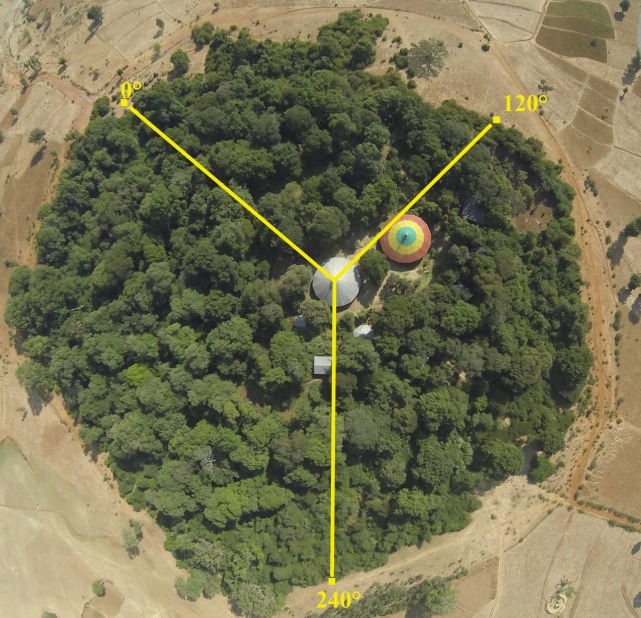
Transect design for the quantification of plant species richness, density, and biomass in 44 church forests in northern Ethiopia.Modified Gentry transects were established in each forest at three cardinal directions (0°, 120°, and 240°) from the church center out towards the edge of the forest. Each transect was 2 m wide and the length depended on the size of the forest. Within each transect every stem > 1 cm was measured and identified as well as any type of disturbance recorded.